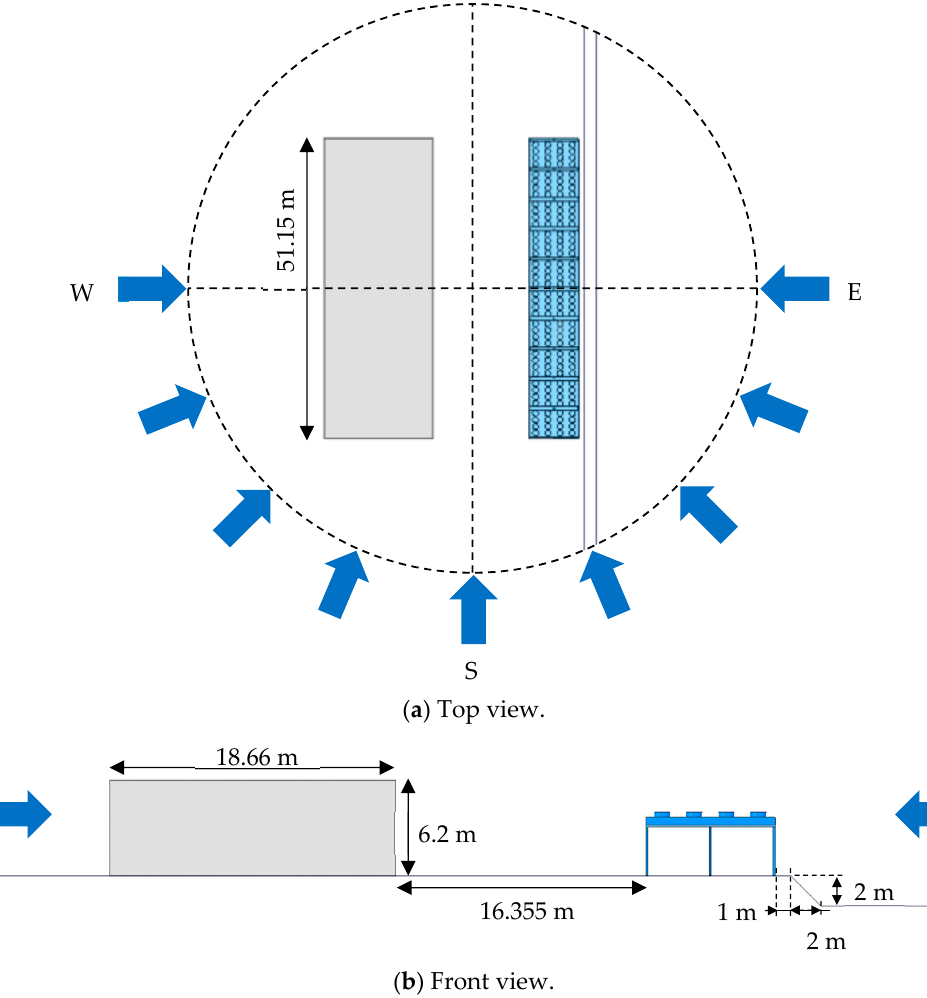
Figure 3. Sketch of the 20 evaporators from top view ( a ) and front view ( b ), with building and ground depression, under different wind conditions in the CFD simulations.